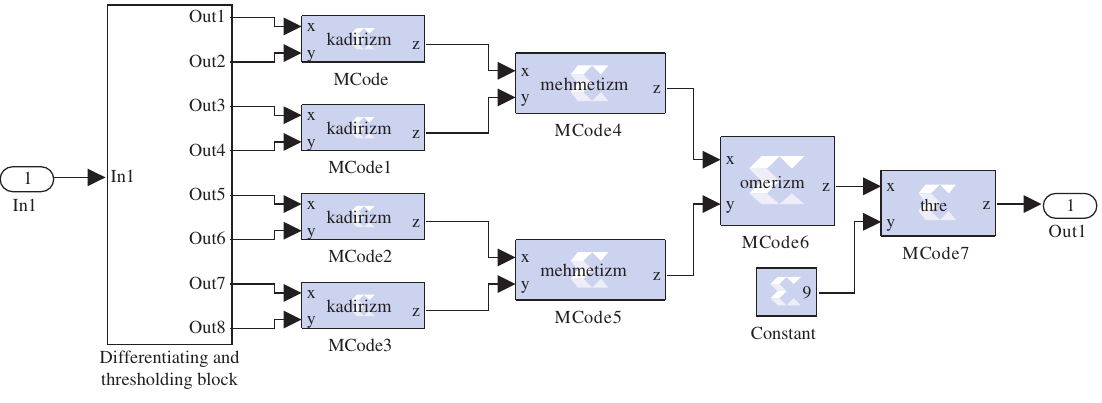
Figure 10. Blocks for TFCM Edge Detection.